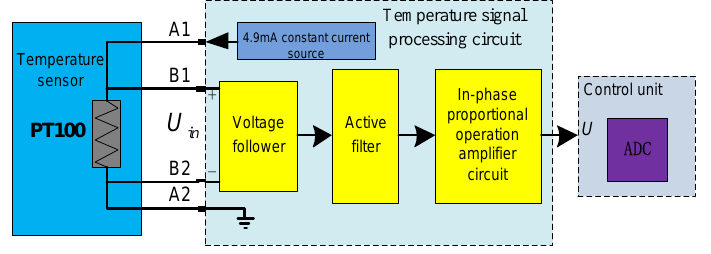
Figure 5. Functional block diagram for temperature signal processing.